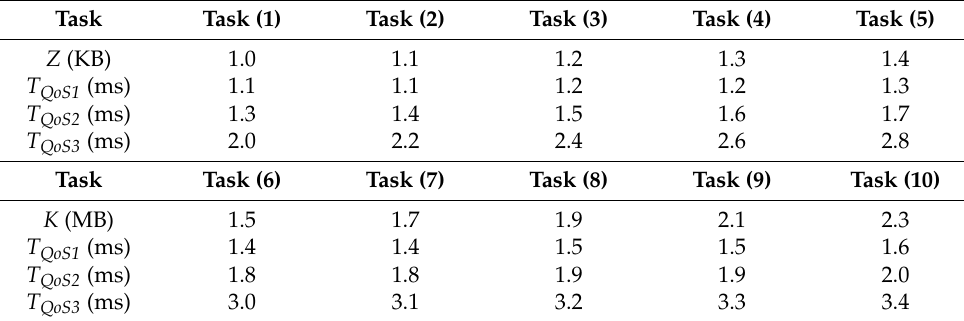
Table 7. Task specifications of gateway devices (GW).